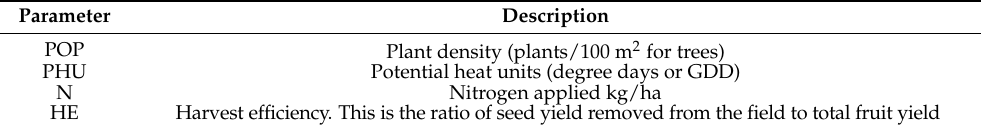
Table 2. Relevant Management Parameter